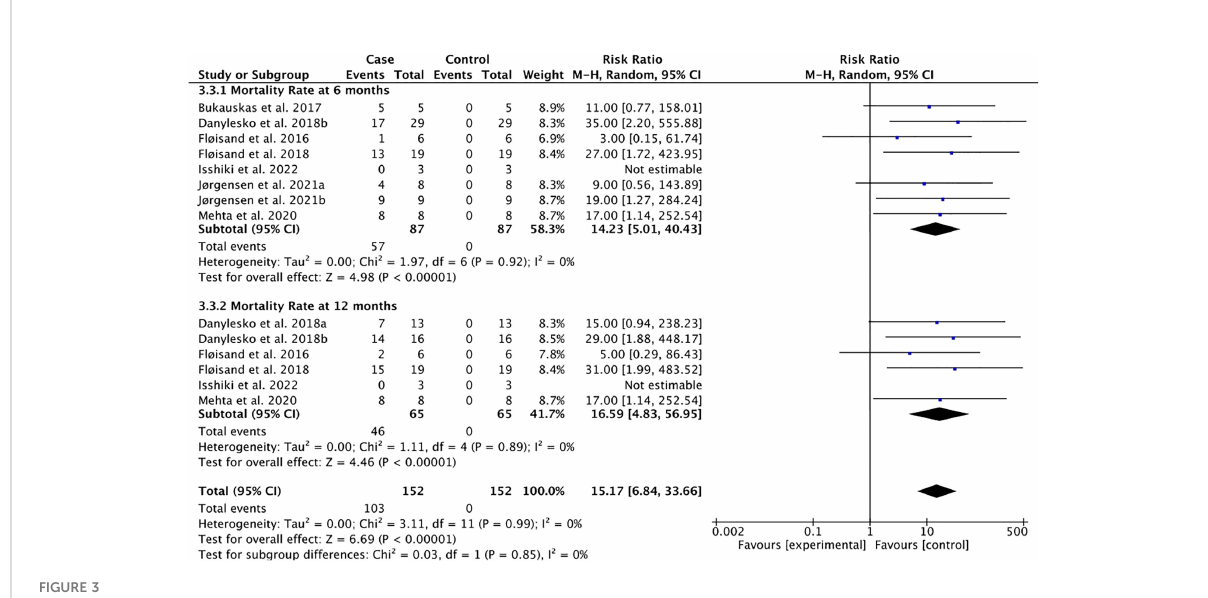
FIGURE 3 Mortality rate following the use of vedolizumab for